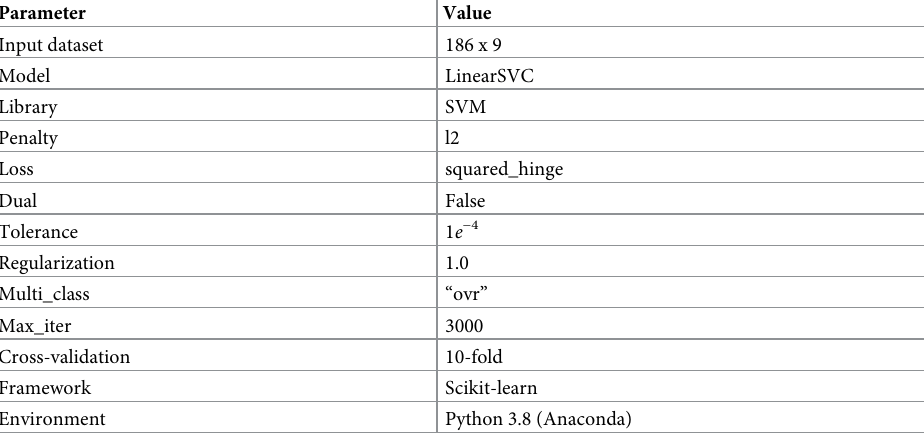
Table 4. A summary of L-SVC model specifications utilized for